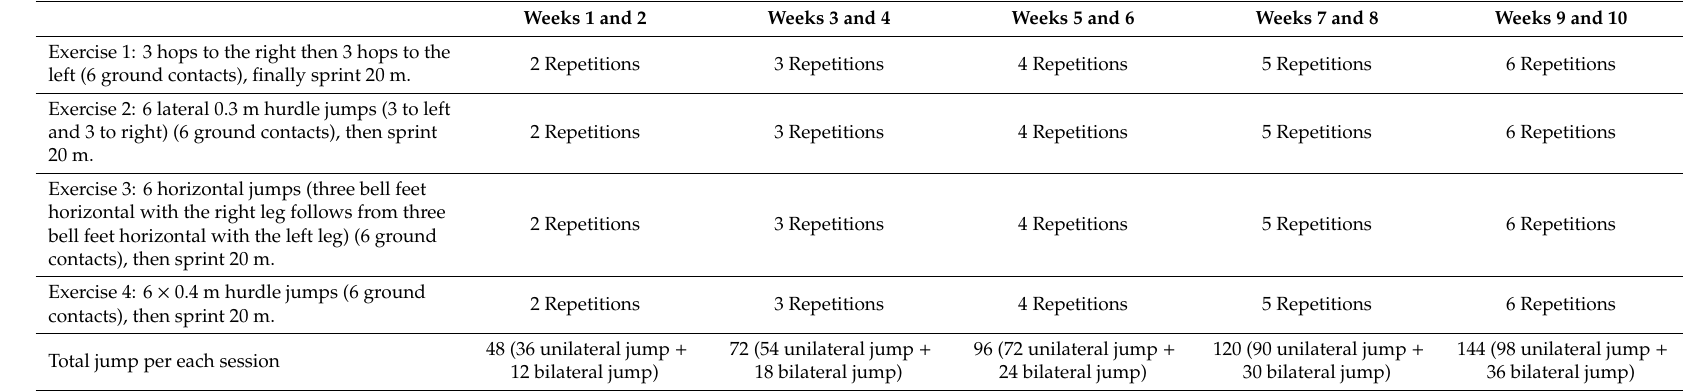
Table 2. Details of two types of plyometric